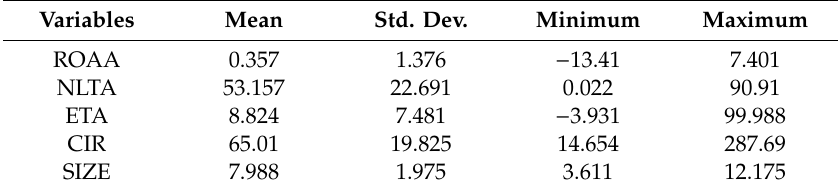
Table 2. Summary of